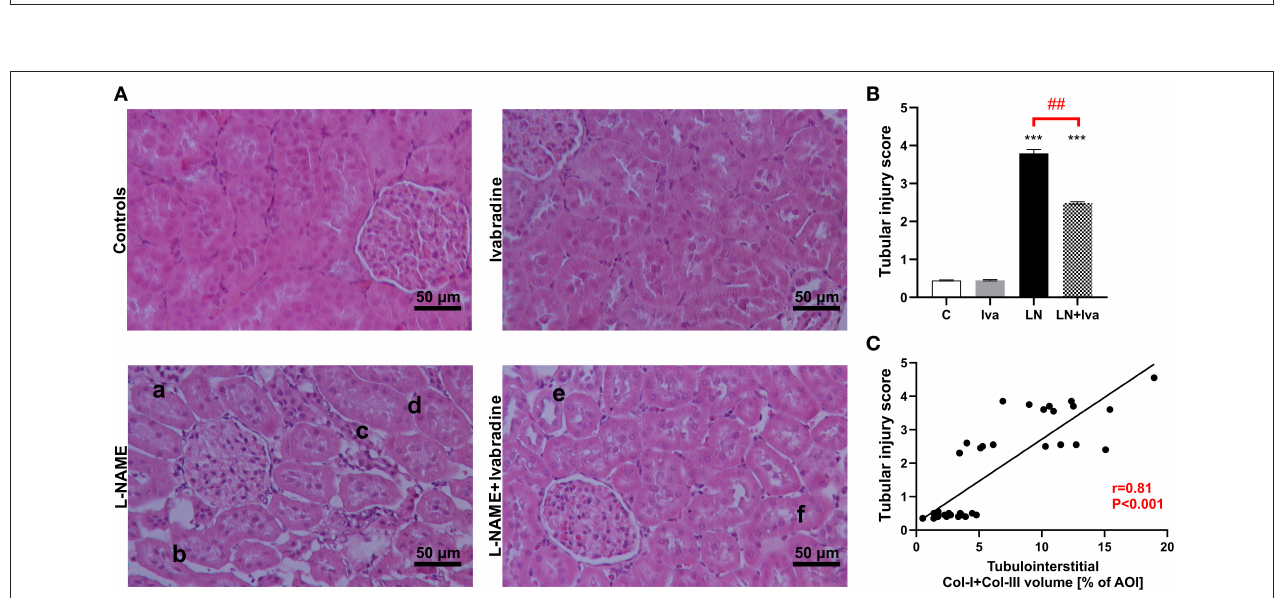
FIGURE 4 | Effect of ivabradine on tubular injury (A,B) and the relationship between tubular injury score and tubulointerstitial fibrosis (C) in L-NAME-induced hypertension after 4 weeks of treatment. For (A) : H-E-stained sections at 100x magnification using transmitted light microscopy; a, tubular cast; b, tubular atrophy and interstitial thickening; c, interstitial cellular infiltration; d, tubular basal membrane thickening; e, tubular dilatation; f, tubular cell sloughing. For (B) : C, controls; Iva, ivabradine; LN, L-NAME; n = 9 animals per group. One-way two-tailed ANOVA followed by Holm–Sidak post - hoc test; *** P < 0.001 vs. C; ## P < 0.01 vs. LN. For (C) : AOI, area of interest; Col-I, type I collagen; Col-III, type III collagen. Spearman correlation; n = 9 animals per group.